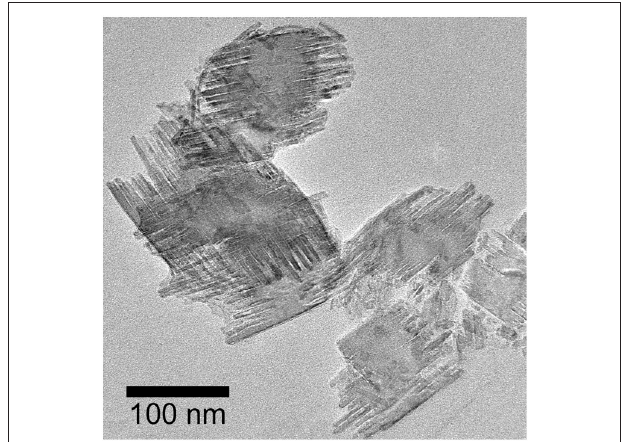
FIGURE 1 | Transmission electron micrograph of the lepidocrocite